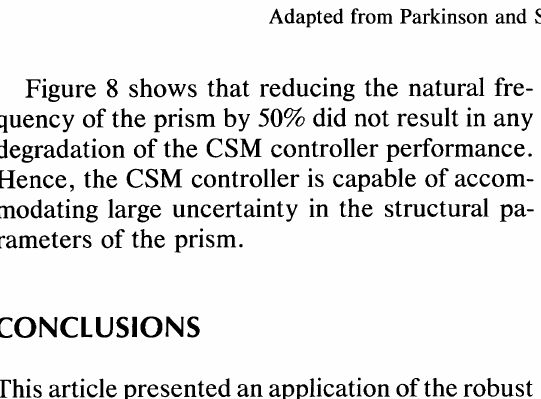
FIGURE 6(b) Time response of y of the controlled prism, y(O) = 0.5, U = 2.